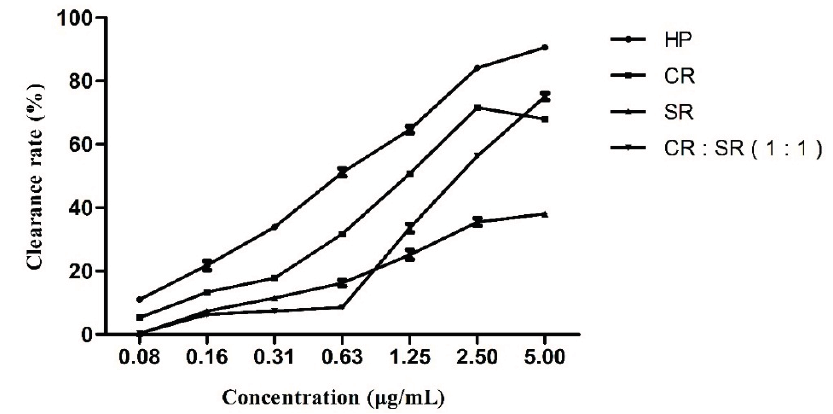
Figure 1. The DPPH free radical scavenging activities of essential oil from CR, SR, and HP CR–SR.